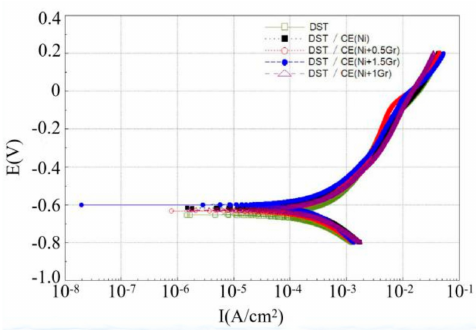
Figure 8. Tafel curve of dimple surface texture obtained under di ff erent conditions.